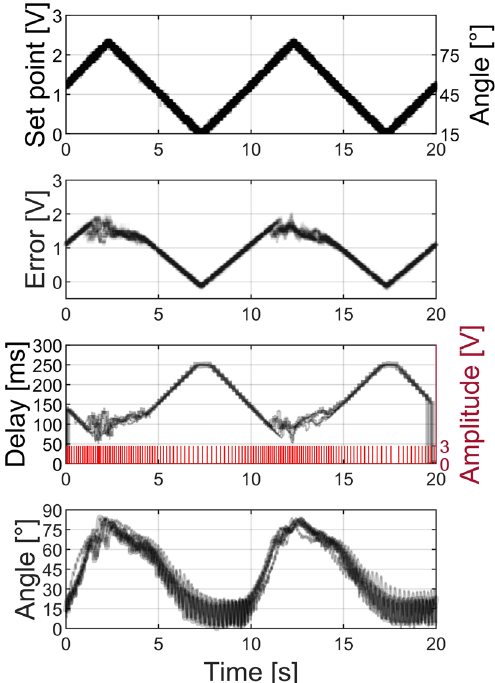
Figure 6. A cyclic voltage ramp set point is applied to generate movement patterns of a locust’s leg. The error signal between set point and feedback signals is converted into a stimulation pulse pattern (red), and a corresponding inter-pulse delay. The stimulation pattern triggers a response in the leg angle, which is extracted from video recordings. The black traces show 5 repetitions of the same experiment with the thicker black traces corresponding to the indicated pulse pattern.